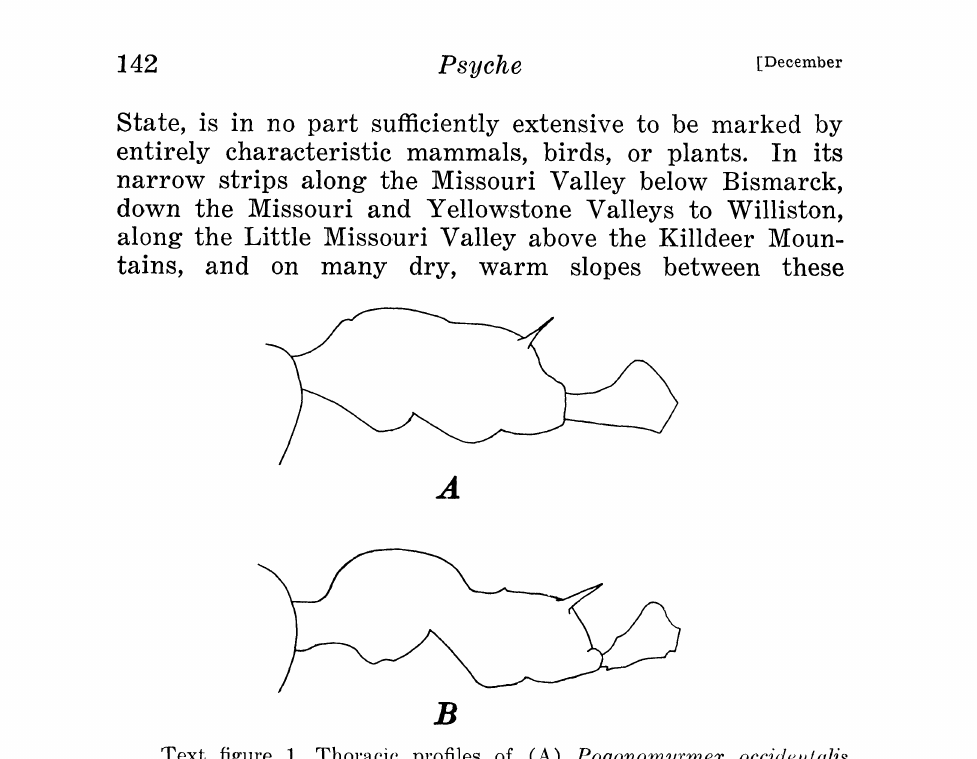
Text figure 1. Thoracic profiles of (A) Pogonomyrmex occidenlalis (Cresson) and (B) Veromessor lobognathc (Andrews), both